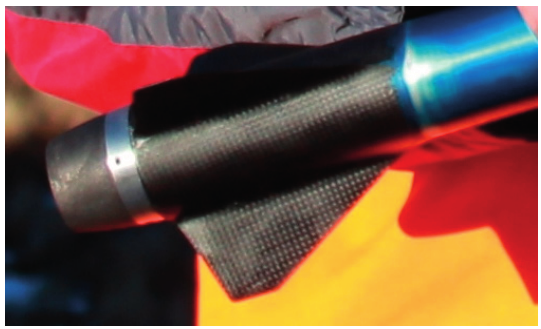
Figure 1. Milly—Tail fins and tapered tail cone containing graphite expander.